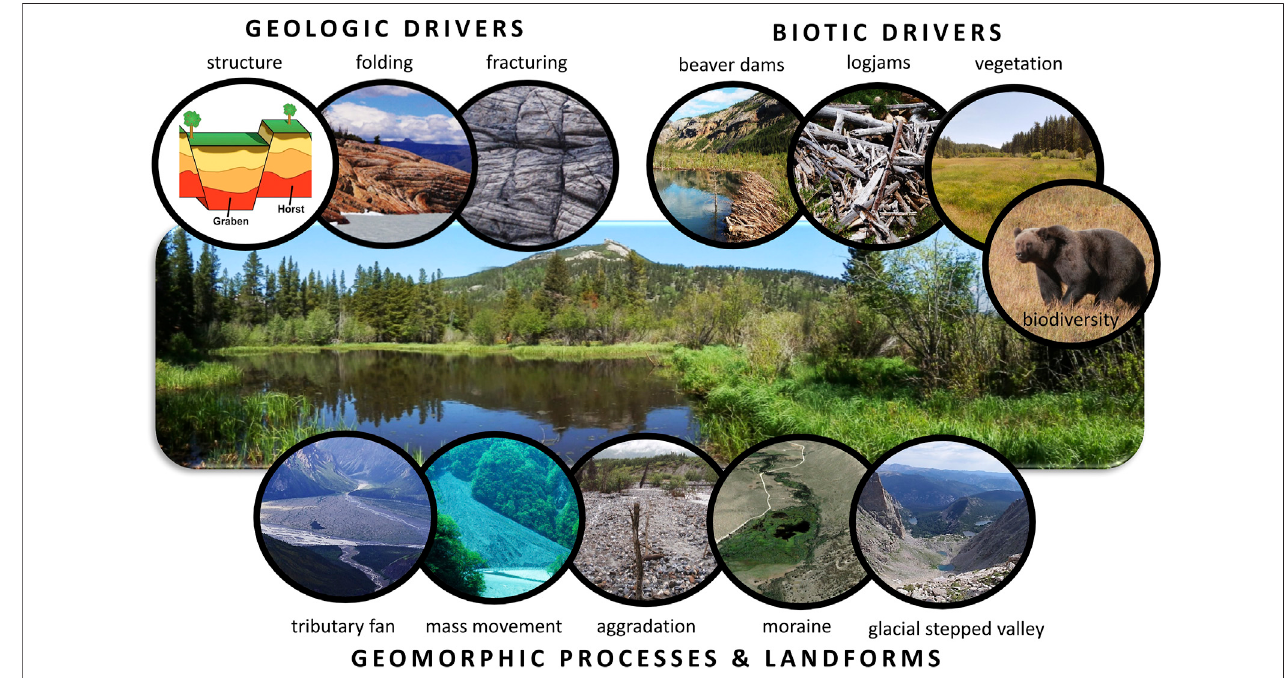
FIGURE 4 | Geologic drivers, biotic drivers, and geomorphic processes and landforms that can promote formation of a river-wetland stream corridor (inset “ structure ” diagram from usgs.gov).